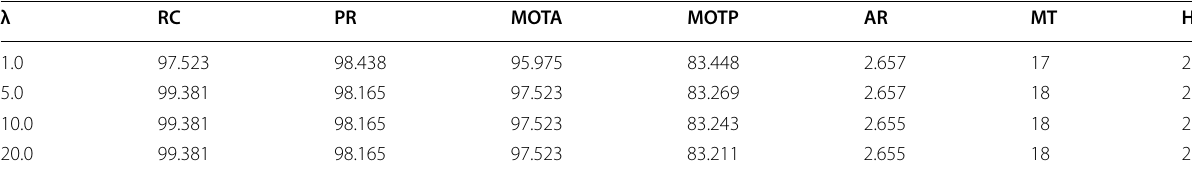
Table 3 Quantitative evaluation tracking results with different